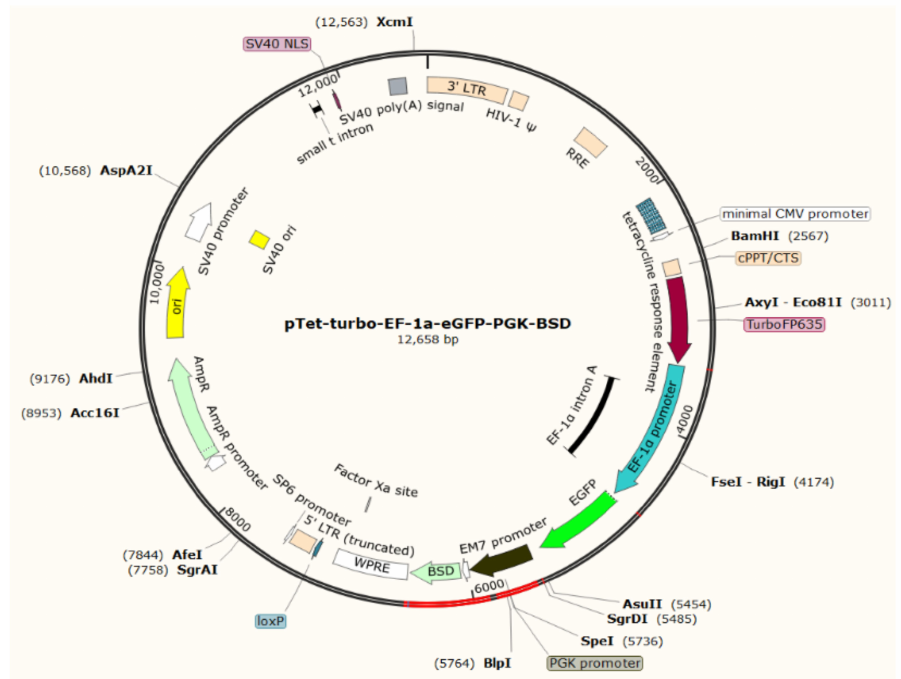
Figure A1. Map of plasmid